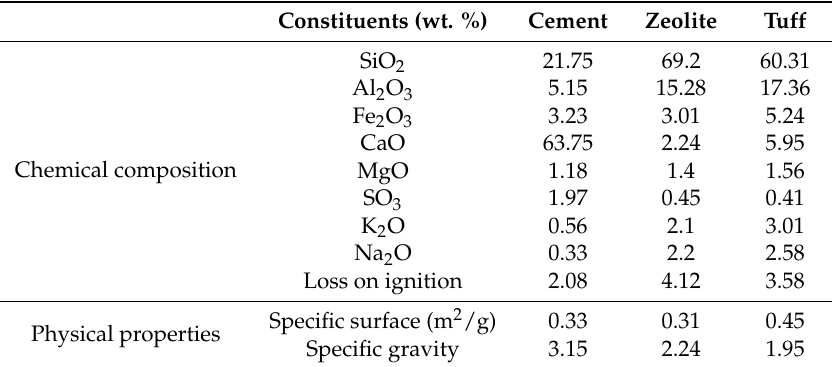
Table 1. Chemical composition and physical properties of cement, zeolite and tuff. Constituents (wt.